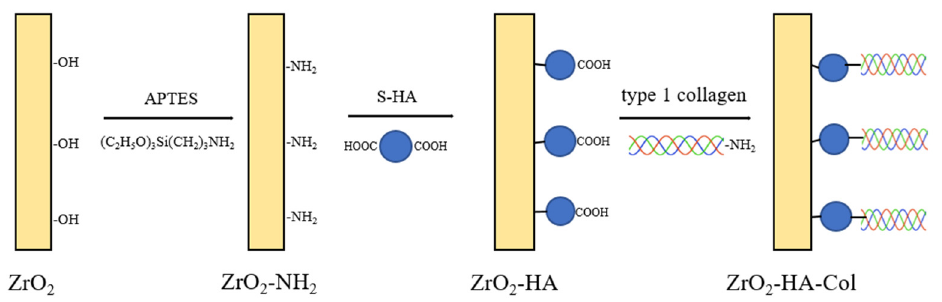
Figure 2. Schematic diagram showing the process of chemically bonding nHA particles to the surface of zirconia and subsequently immobilizing type I collagen.